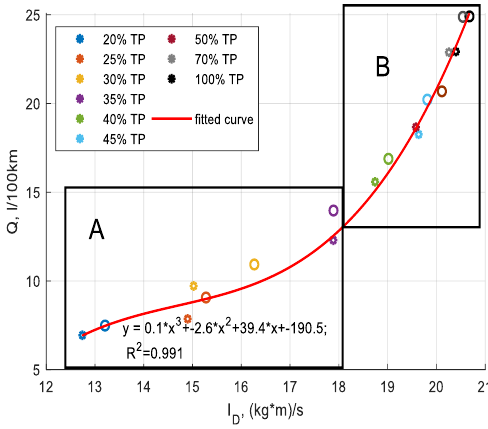
Fig. 9. Index of acceleration dynamics for throttle